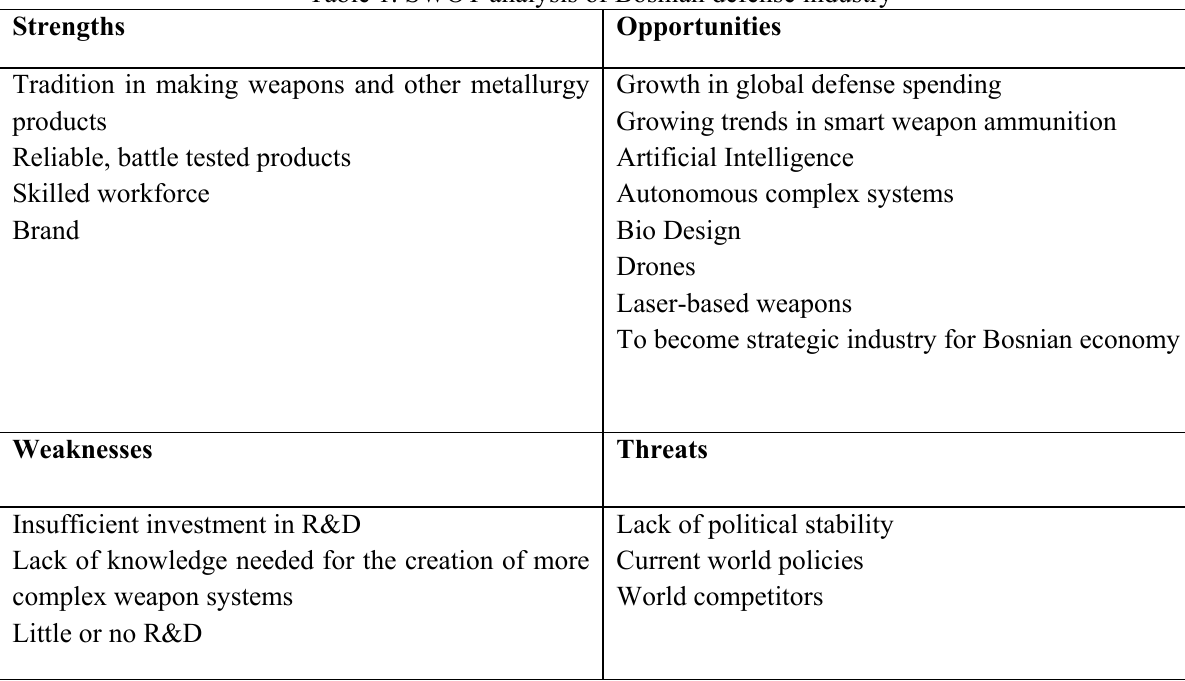
Table 1. SWOT analysis of Bosnian defense